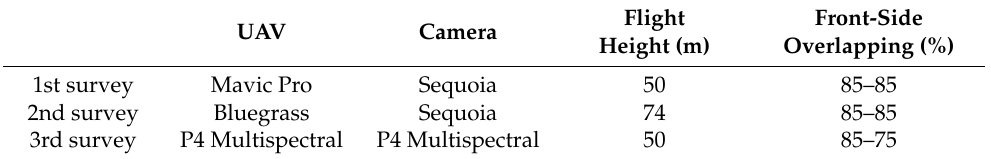
Table 4. Flight settings of each